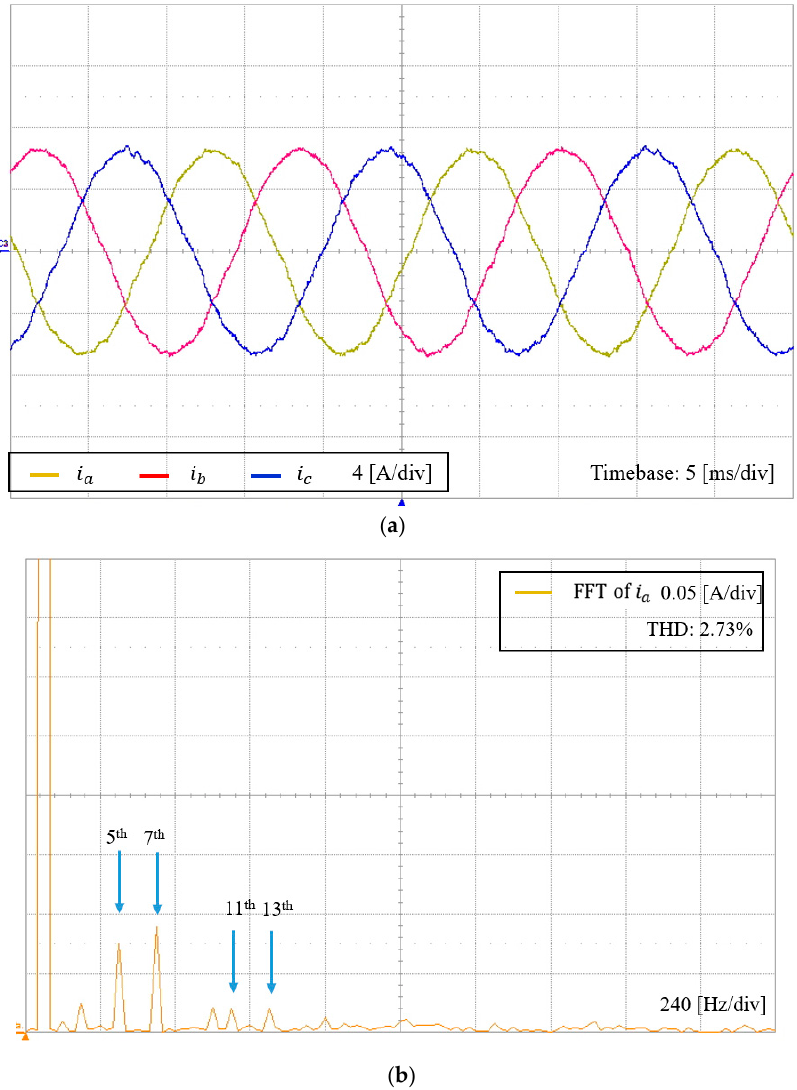
Figure 18. Experimental results of the inverter currents for the proposed control scheme under distorted grid condition. ( a ) Phase current waveforms; ( b ) FFT result of a -phase current.